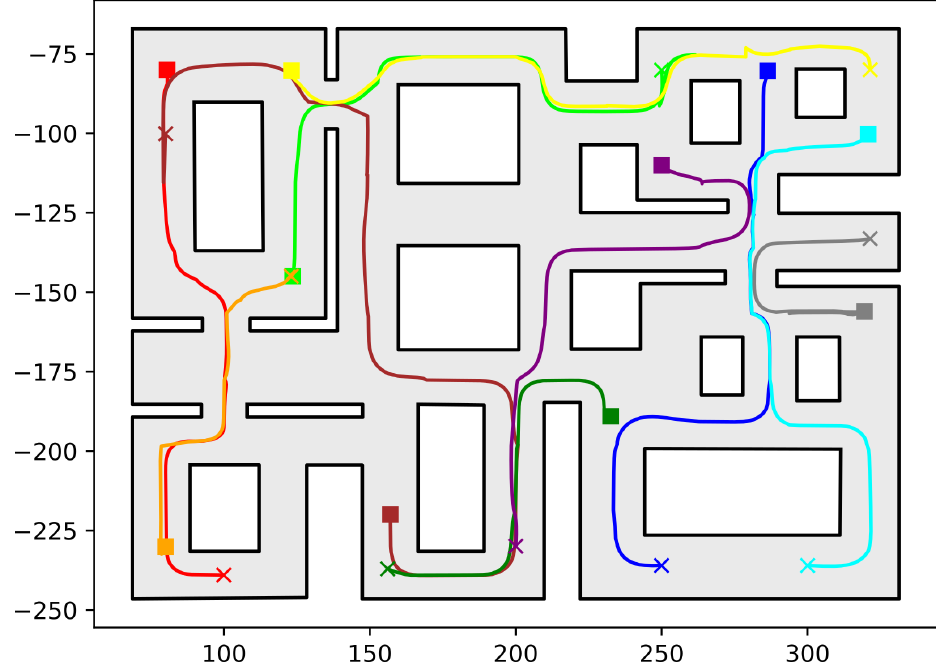
Figure 9. Executed trajectories of the ten-robot case. Squares indicate initial positions, whereas the corresponding goal positions are depicted using crosses. Robot #1 (red); Robot #2 (green); Robot #3 (dark red); Robot #4 (orange); Robot #5 (yellow); Robot #6 (dark green); Robot #7 (blue); Robot #8 (cyan); Robot #9 (purple); Robot #10 (grey). The axes units are in (dm).